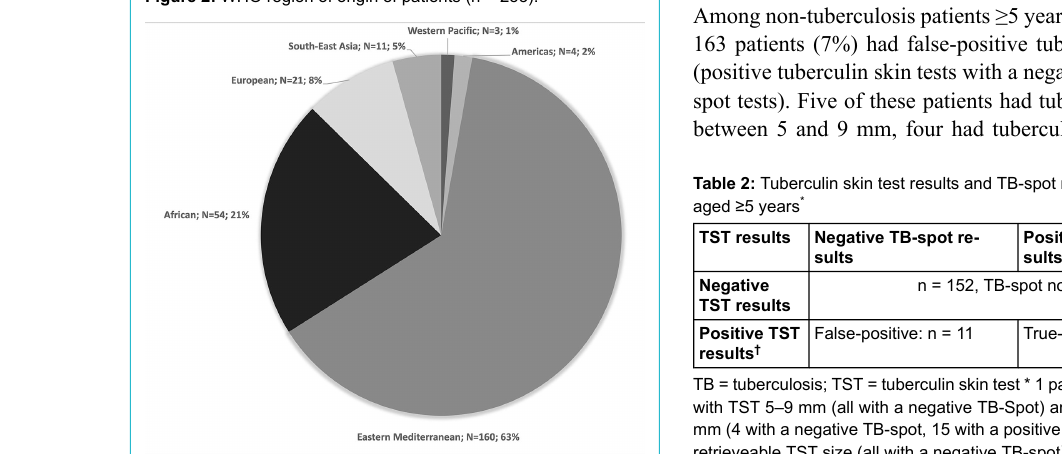
Figure 2: WHO region of origin of patients (n = 253).